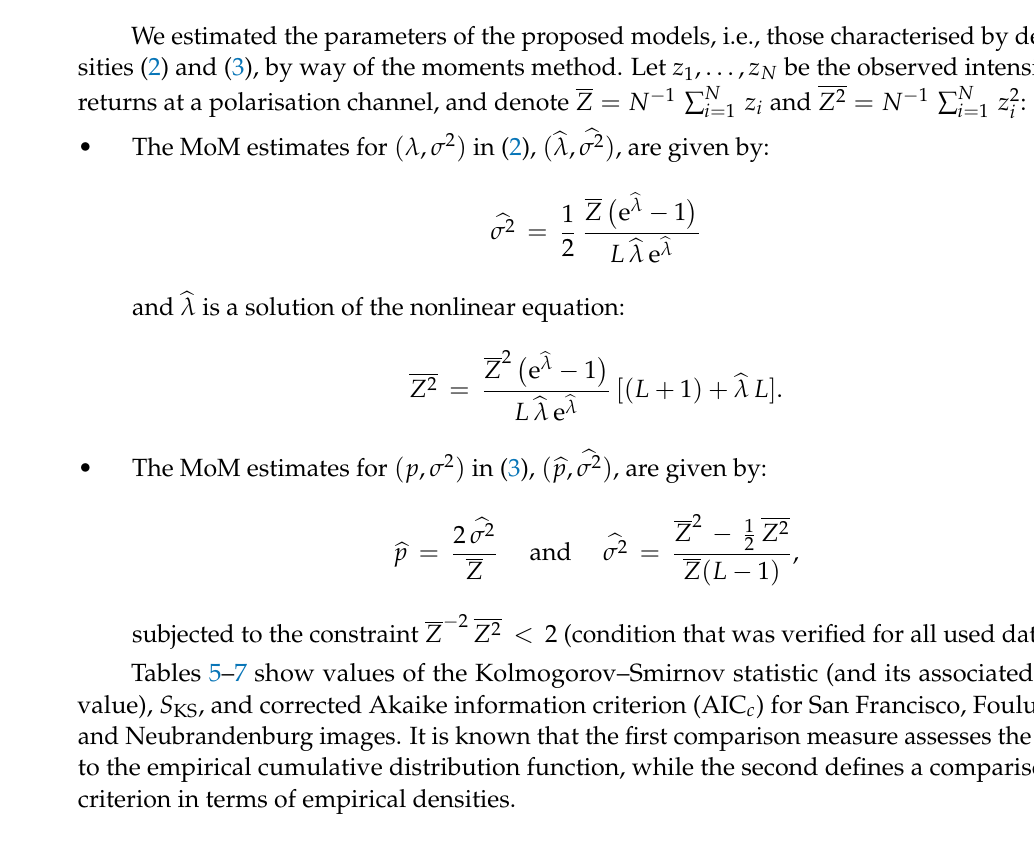
Table 5. Results of fitting intensities of San Francisco PolSAR data, for L fixed. AIC c